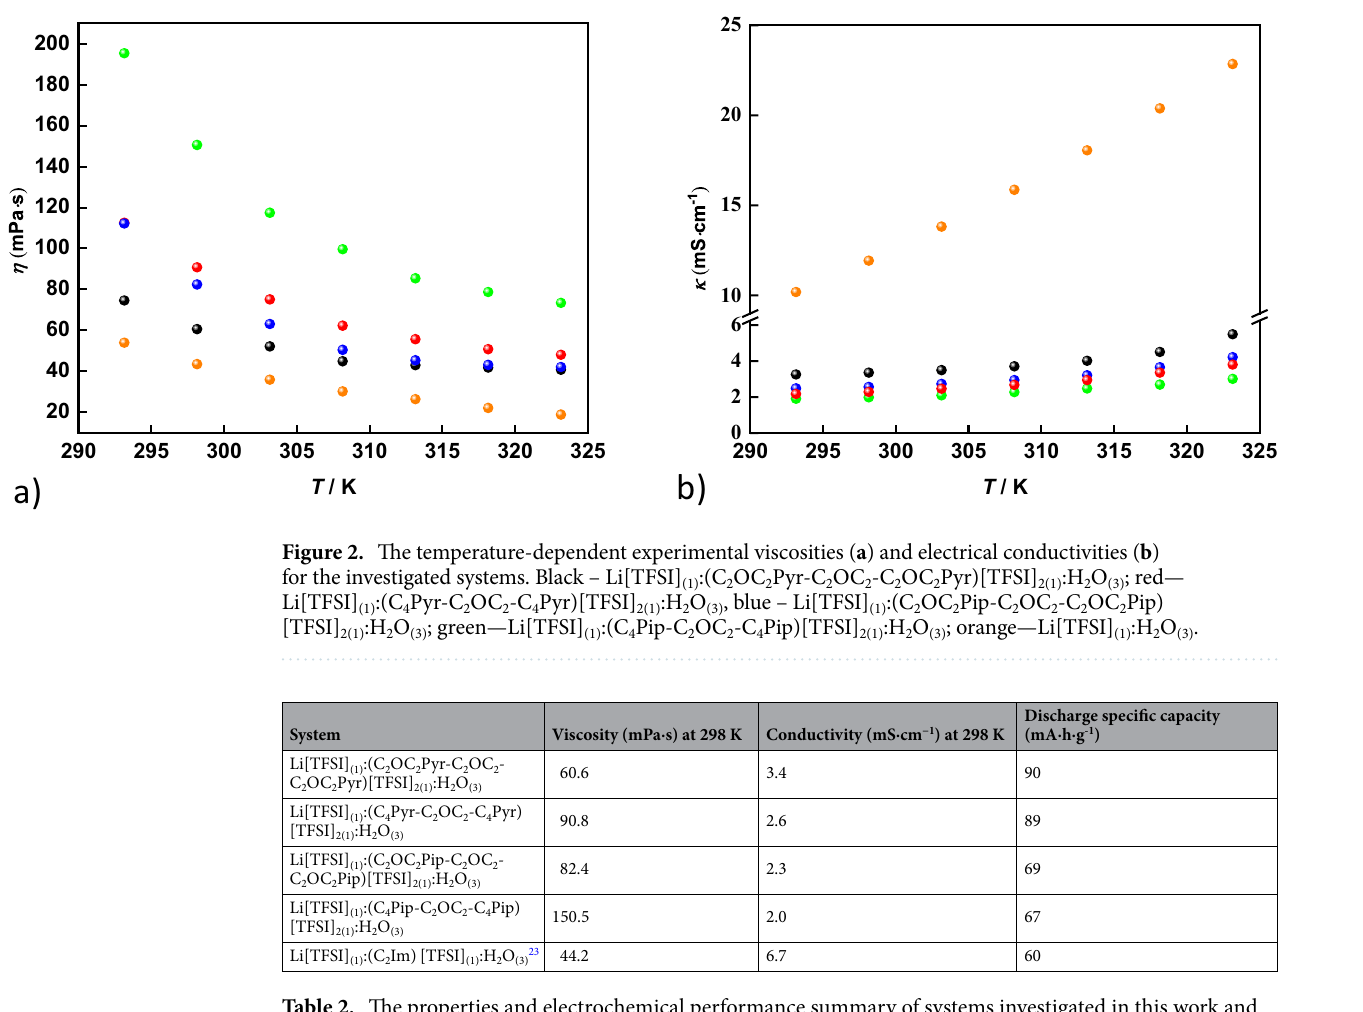
Table 2. The properties and electrochemical performance summary of systems investigated in this work and in the work by Becker et al. 23 .